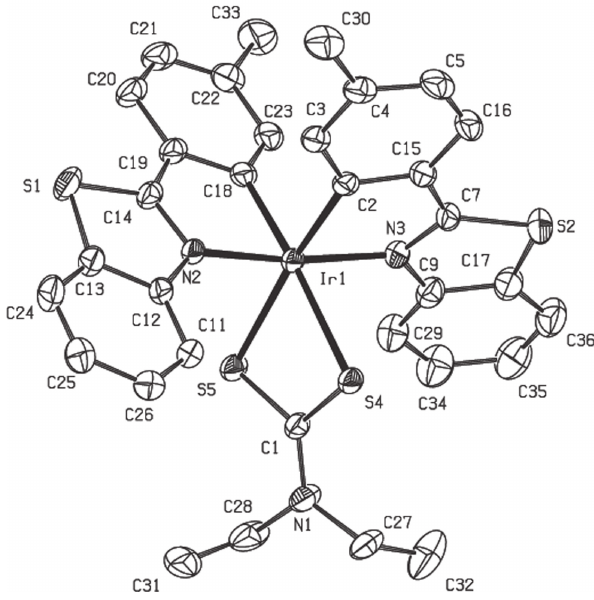
Table 1: Data collection and